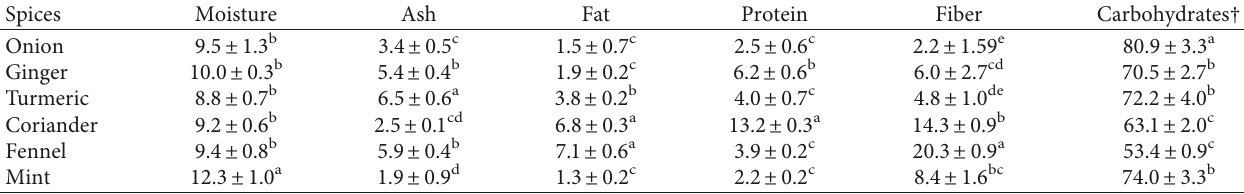
Table 1: Proximate composition of spice powders on dry weight basis (g/100g).